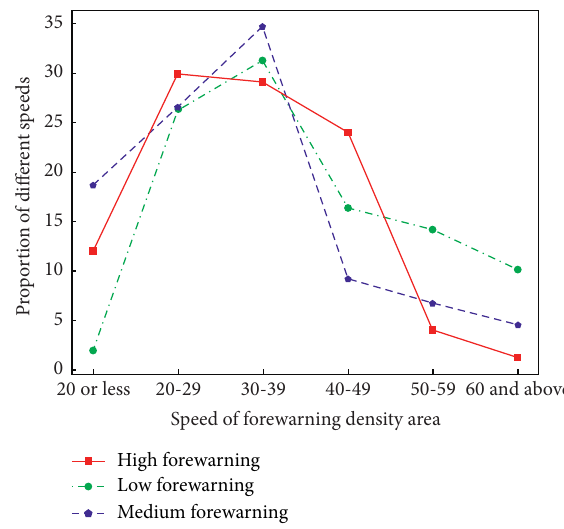
Figure 9: The proportion of different speeds in each forewarning density area.